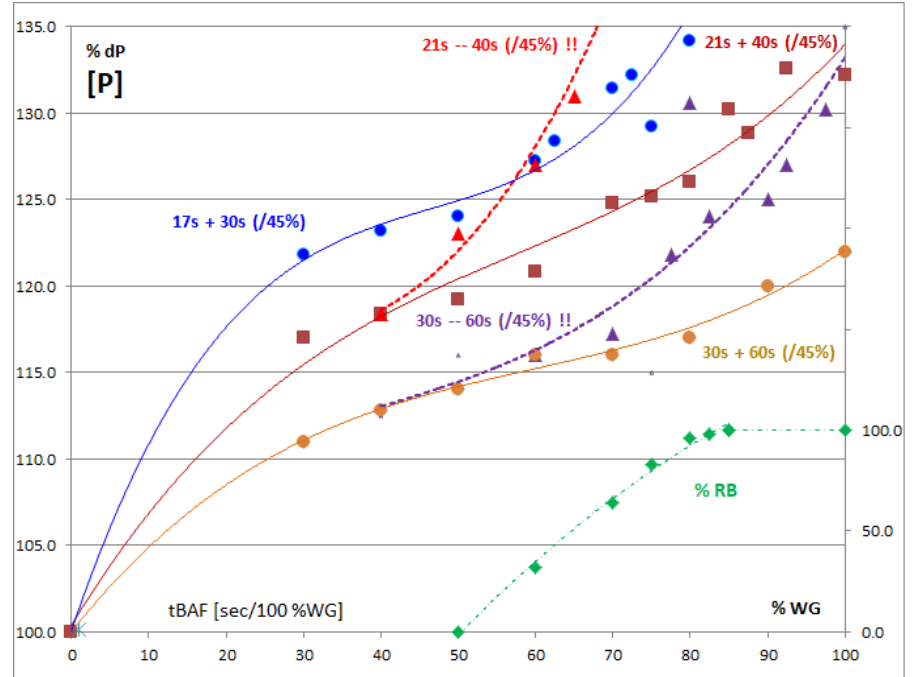
Figure 5. Influence of second slope closing on overpressure for a hydropower plant equipped with Kaplan turbine performed in 2017 [88].